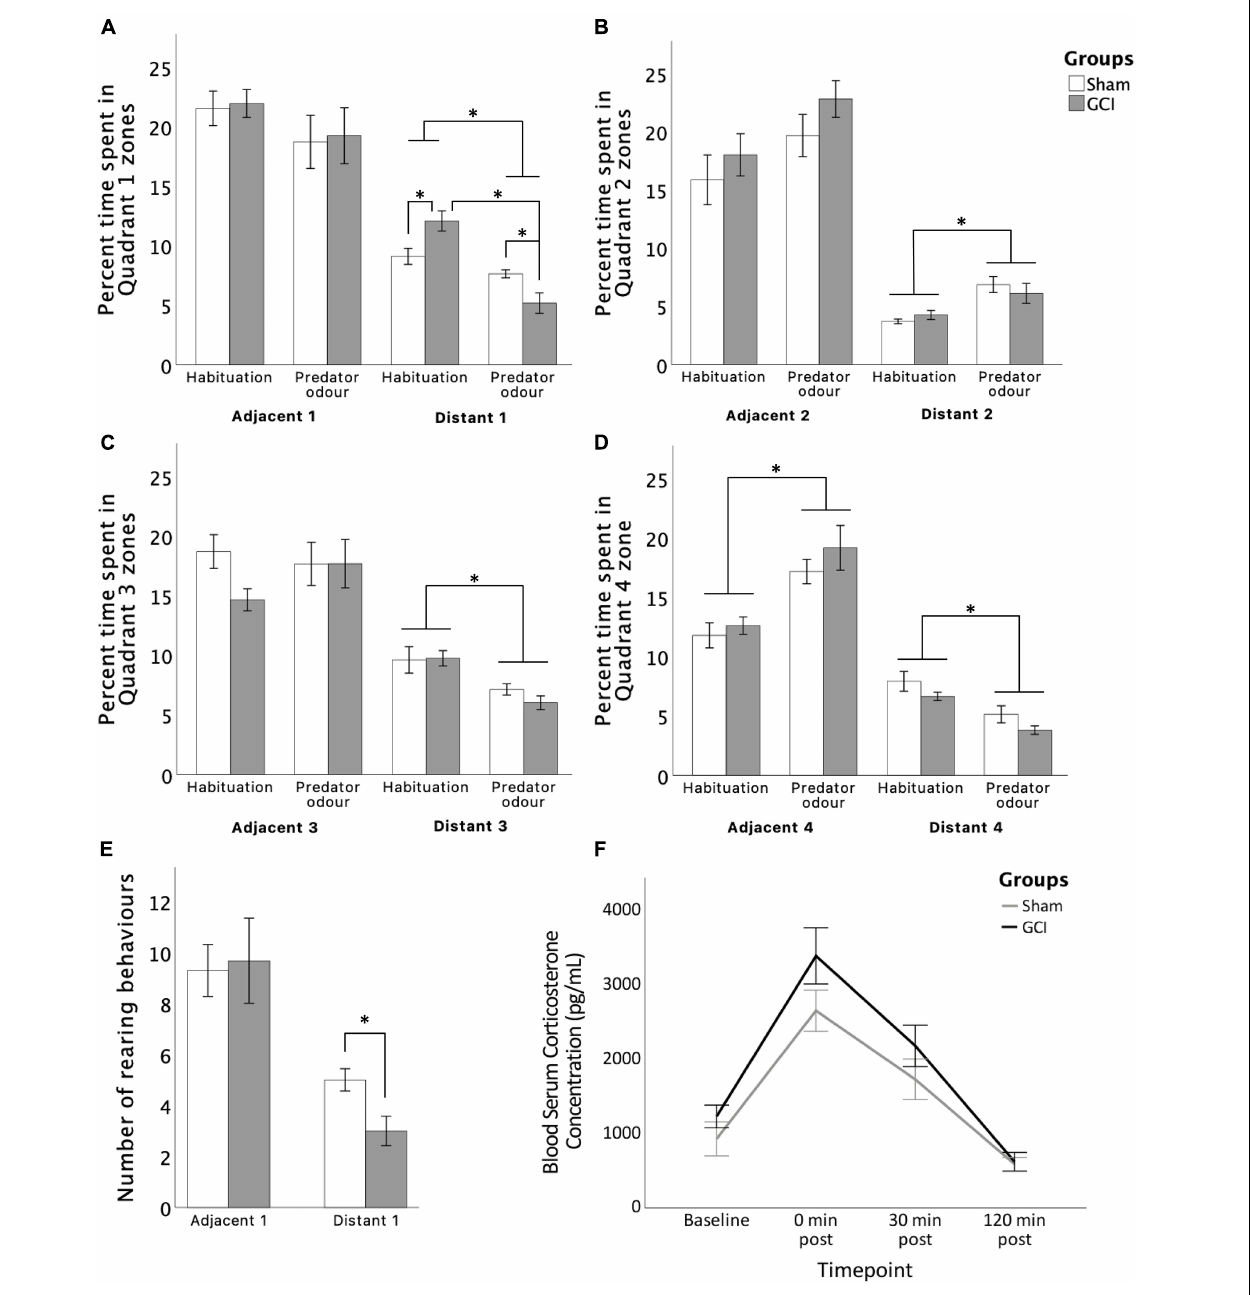
FIGURE 5 | Effects of GCI on PO test performance and circulatory blood corticosterone levels. Bar graphs show time spent in each zone (A–D) and number of rearing behaviours in Quadrant 1 (E) . Line graph presents blood serum corticosterone levels at baseline and at 0, 30, and 120 min post PO completion (F) . Values are presented as mean ± S.E.M. ∗ Indicates statistical significance at p < 0.05. GCI, global cerebral ischemia.